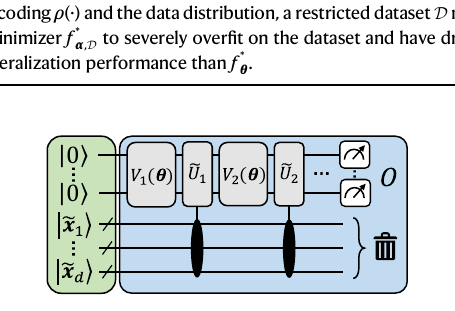
Fig. 3 | An illustrative explicit model approximating a data re-uploading cir- cuit. The circuit acts n working qubits and dp encoding qubits. Pauli-X rotations encodebit-stringdescriptions e x i 2 f 0,1 g p ofthe d input components x i 2 R